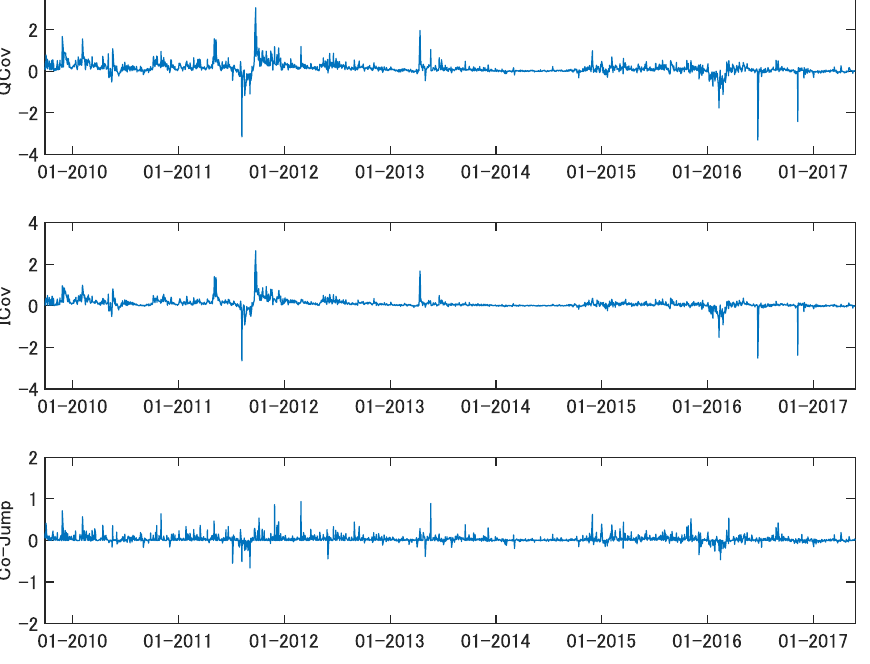
Figure 3. Estimates of Quadratic Covariation, Integrated Covolatility, and Jump Co-variability for Crude Oil and Gold Futures. Figure 3 shows the ( 2,1 ) -elements of ˜ Σ t , ˜ C t , and ˜ J t